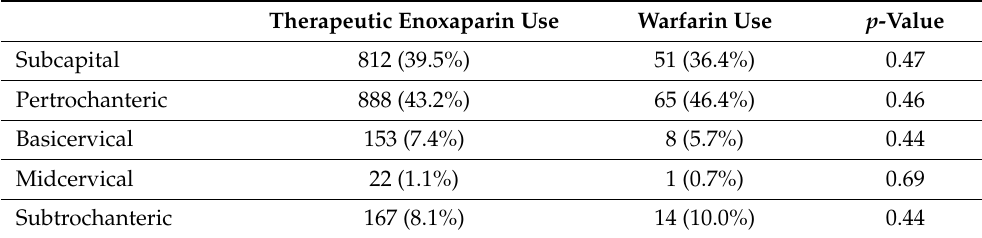
Table 2. Type of diagnosis between